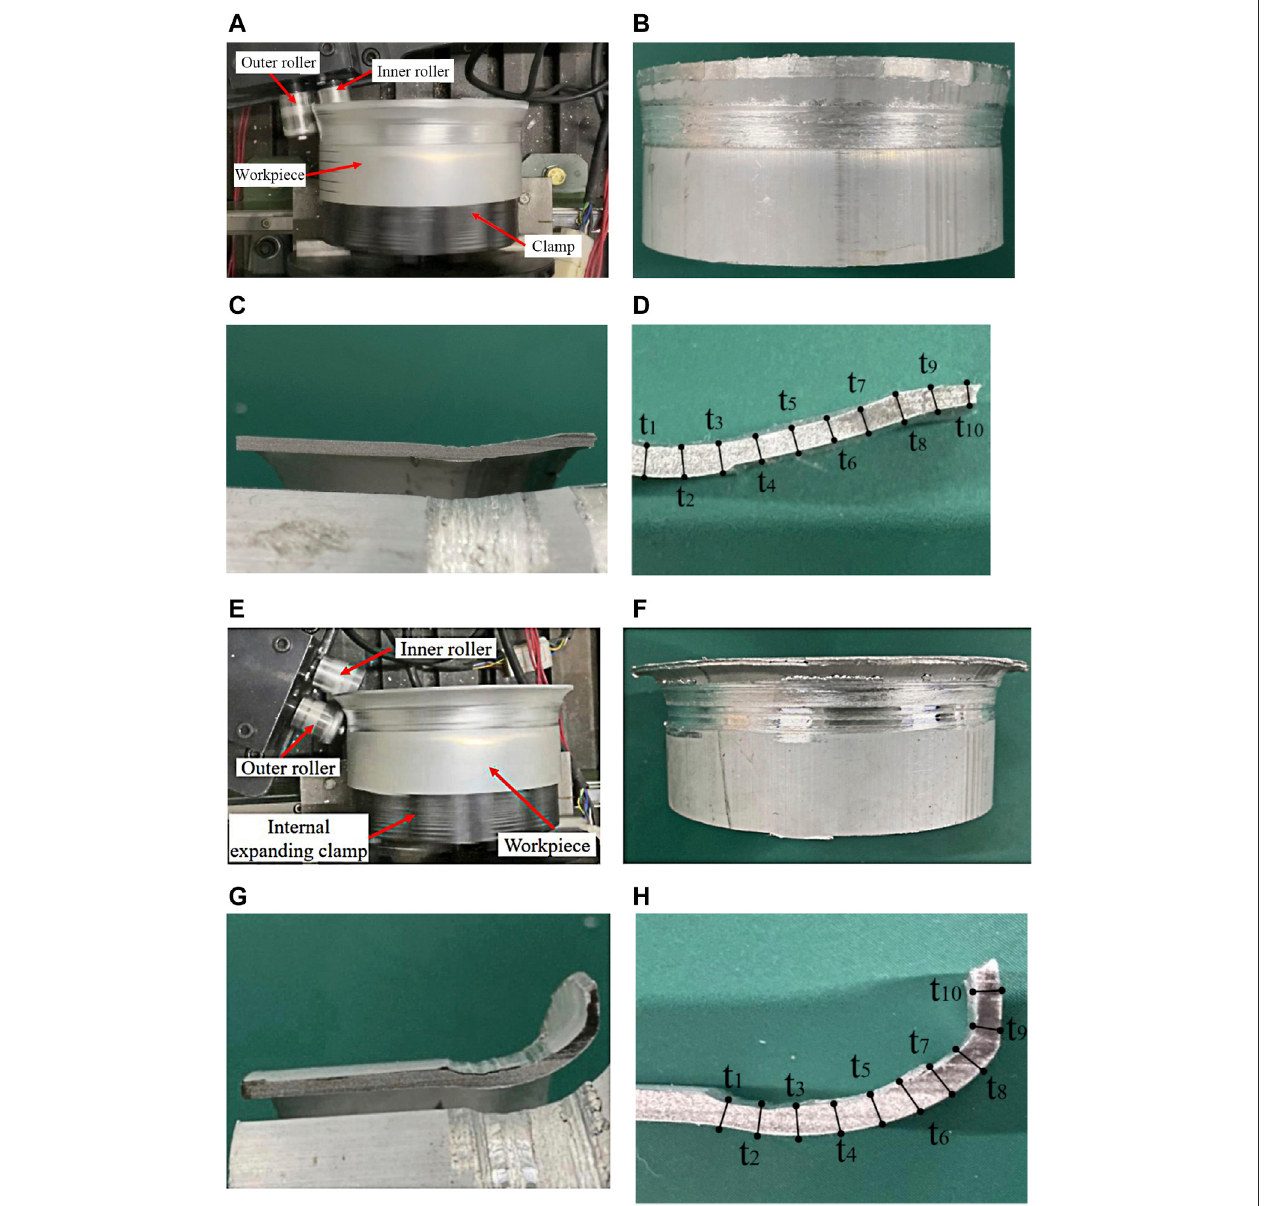
FIGURE10|(A) ExperimentprocessofDRCSfortheexpandingsectionofawindconcentrator. (B) Finalformedsample. (C) Sectionofthesample. (D) Schematic diagram of monitor points for the wall thickness on the sample. (E) Experiment process of DRCS for the expanding section of a wind concentrator. (F) Final formed sample. (G) Section of the sample. (H) Schematic diagram of monitor points for the wall thickness on the sample.